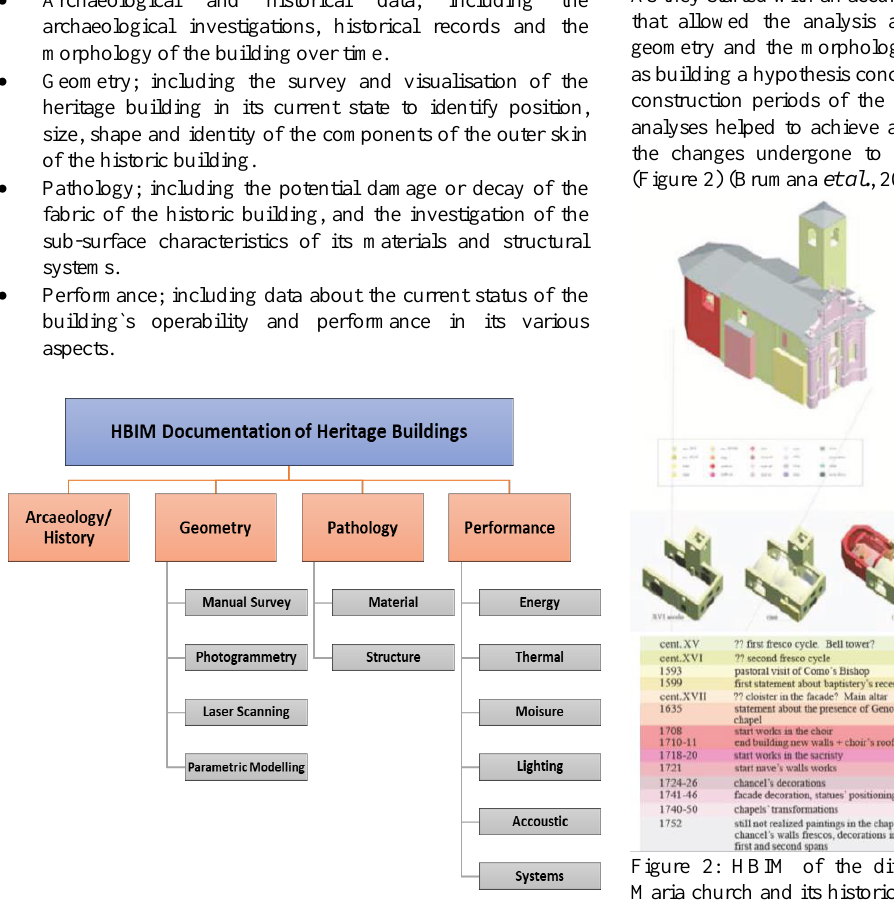
Figure 1 Categorisation of the different domains of data in the documentation of Heritage buildings